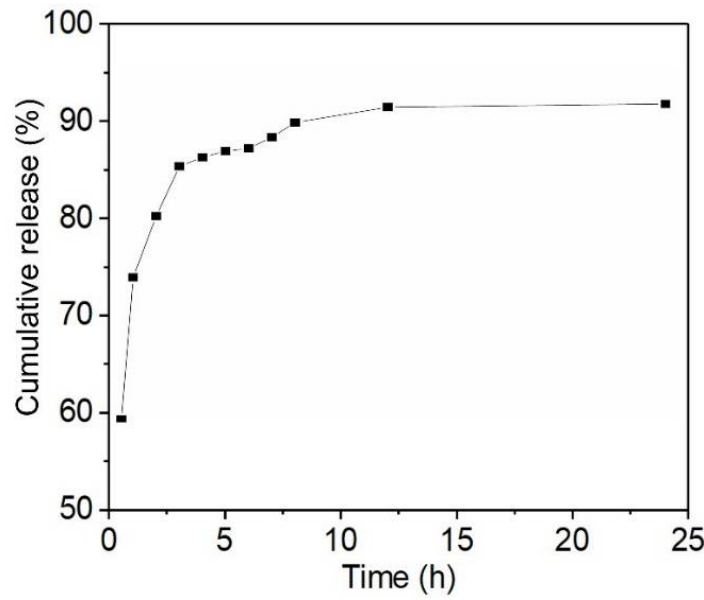
Figure 7. Cumulative drug release curve of NaSA-load cellulose-PEI at different time. Moreover, the drug release behaviors of cellulose-PEI were further analyzed with three pharmacokinetic models, including Zero-order (Equation (6)), First-order (Equation (7)) and Higuchi (Equation (8)) [42,46].